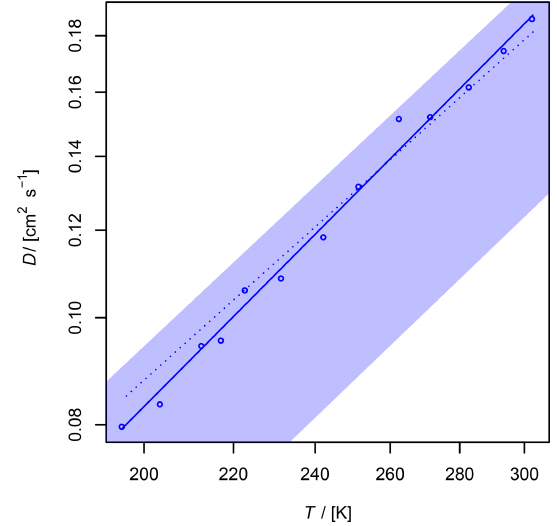
Figure 9. Diffusion coefficient of O 3 in air as a function of temperature. The shaded area shows the diffusion coefficient ex- pected by the Lennard–Jones model. The upper border is cal- culated with D(T, 0 . 8 σ AB , 0 . 8 (cid:15) AB ) and the lower border with D(T, 1 . 2 σ AB , 1 . 2 (cid:15) AB ) using Eq. (1), corresponding to a 20% un- certainty of σ AB and (cid:15) AB . The dotted line is calculated by Fuller’s